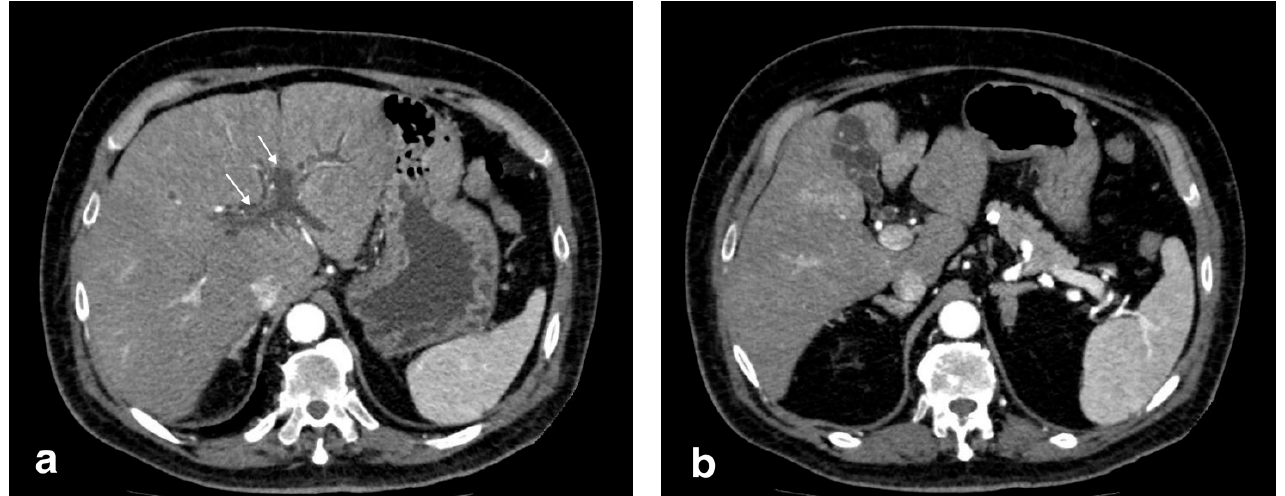
Figure 11. Pylephlebitis in cholecystitis exacerbation: ( a ) massive thrombosis of the portal bifurcation with hyperdensity of portal walls due to pylephlebitis (white arrows) and inhomogeneous attenuation of liver parenchyma in arterial CT scan due to vascular occlusion; ( b ) axial scan: irregular thickening of cholecystic walls with contrast enhancement of liver parenchyma due to pericholecystic edema.